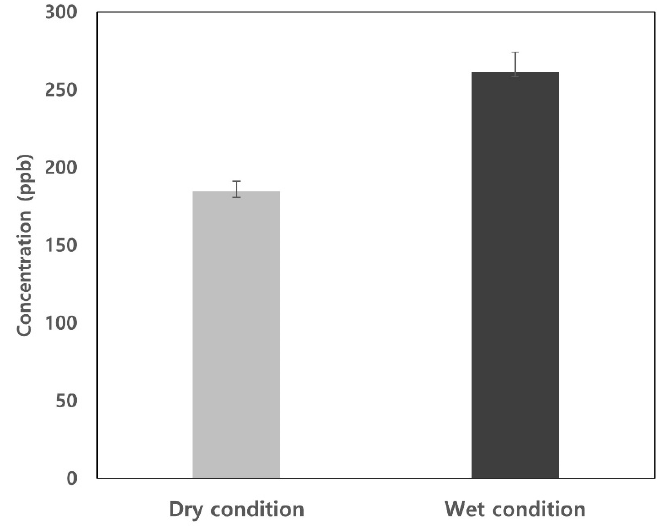
Figure 8. Moisture interference effect for a PID sensor.